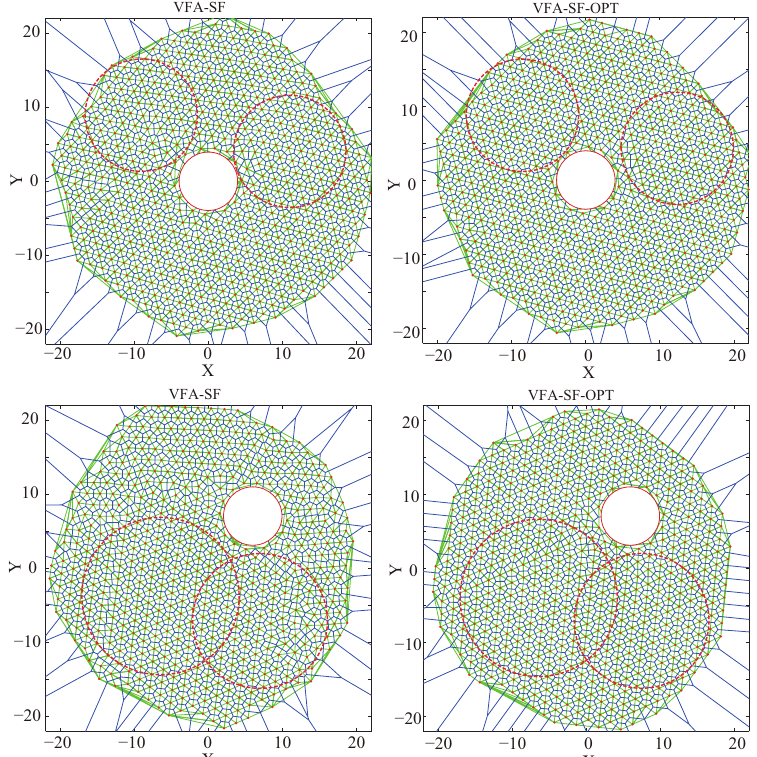
Figure 7. Final node deployments from ( left ) the VFA-SF and ( right ) the VFA-SF-OPT for the circle obstacle cases: ( top ) when circle obstacle is at the center of the target area; ( bottom ) when the circle obstacle is off-center. Red dashed circles, region used to calculate the PCD